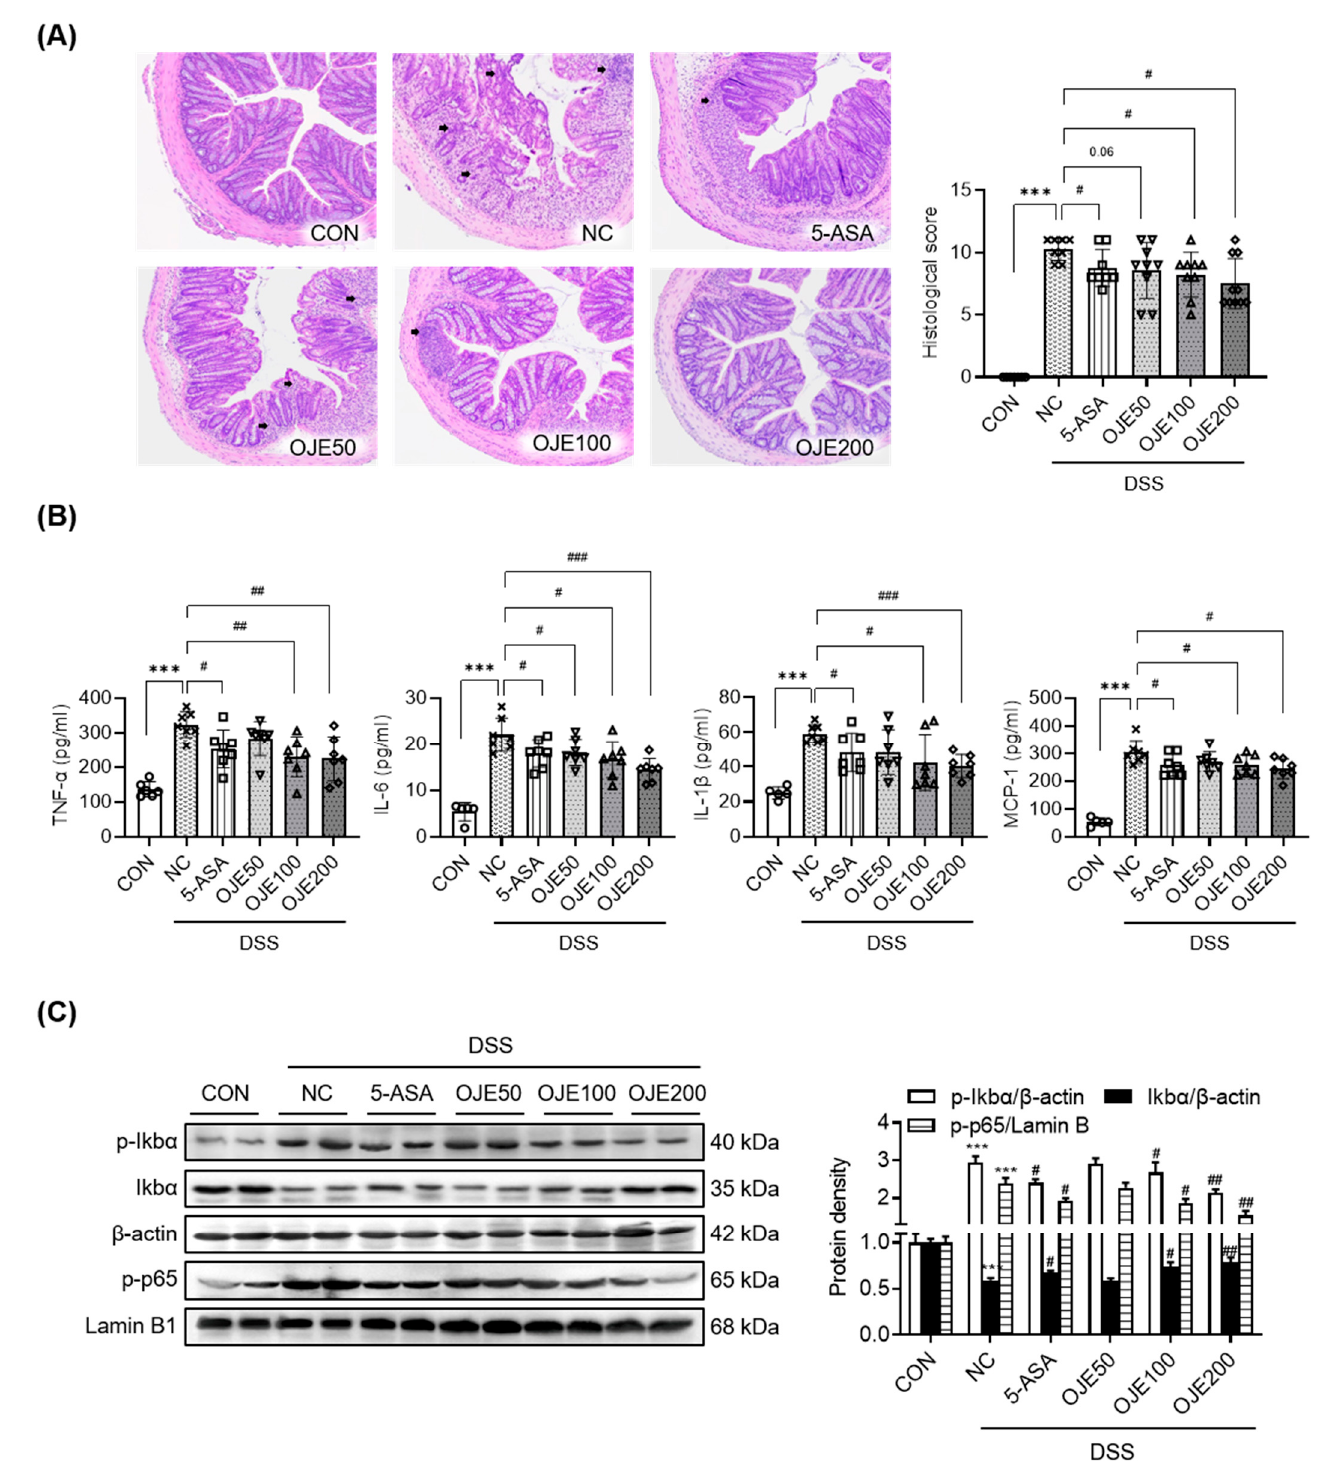
Figure 4. Effects of OJE on the histological change, serum levels, and activation of the NF-kB signaling pathway in mice with DSS-induced colitis. ( A ) H&E-stained colon sections (magnification 400 × ), histological score ( n = 7–10), and ( B ) serum TNF- α , IL-6, IL-1 β and MCP-1 levels as pro-inflammatory cytokines ( n = 6–7). ( C ) Protein levels of total- and phosphorylated-IkBa and -p65 were analyzed via Western blotting. The two lanes show the bands tested in tissue extracts from two representative animals. Protein density was quantified ( n = 6). Values are the mean ± SEM. *** p < 0.001, NC vs. CON; # p < 0.05, ## p < 0.01, and ### p < 0.001, 5-ASA 50 mg/kg, OJE 50 mg/kg, OJE 100 mg/kg, OJE 200 mg/kg vs.